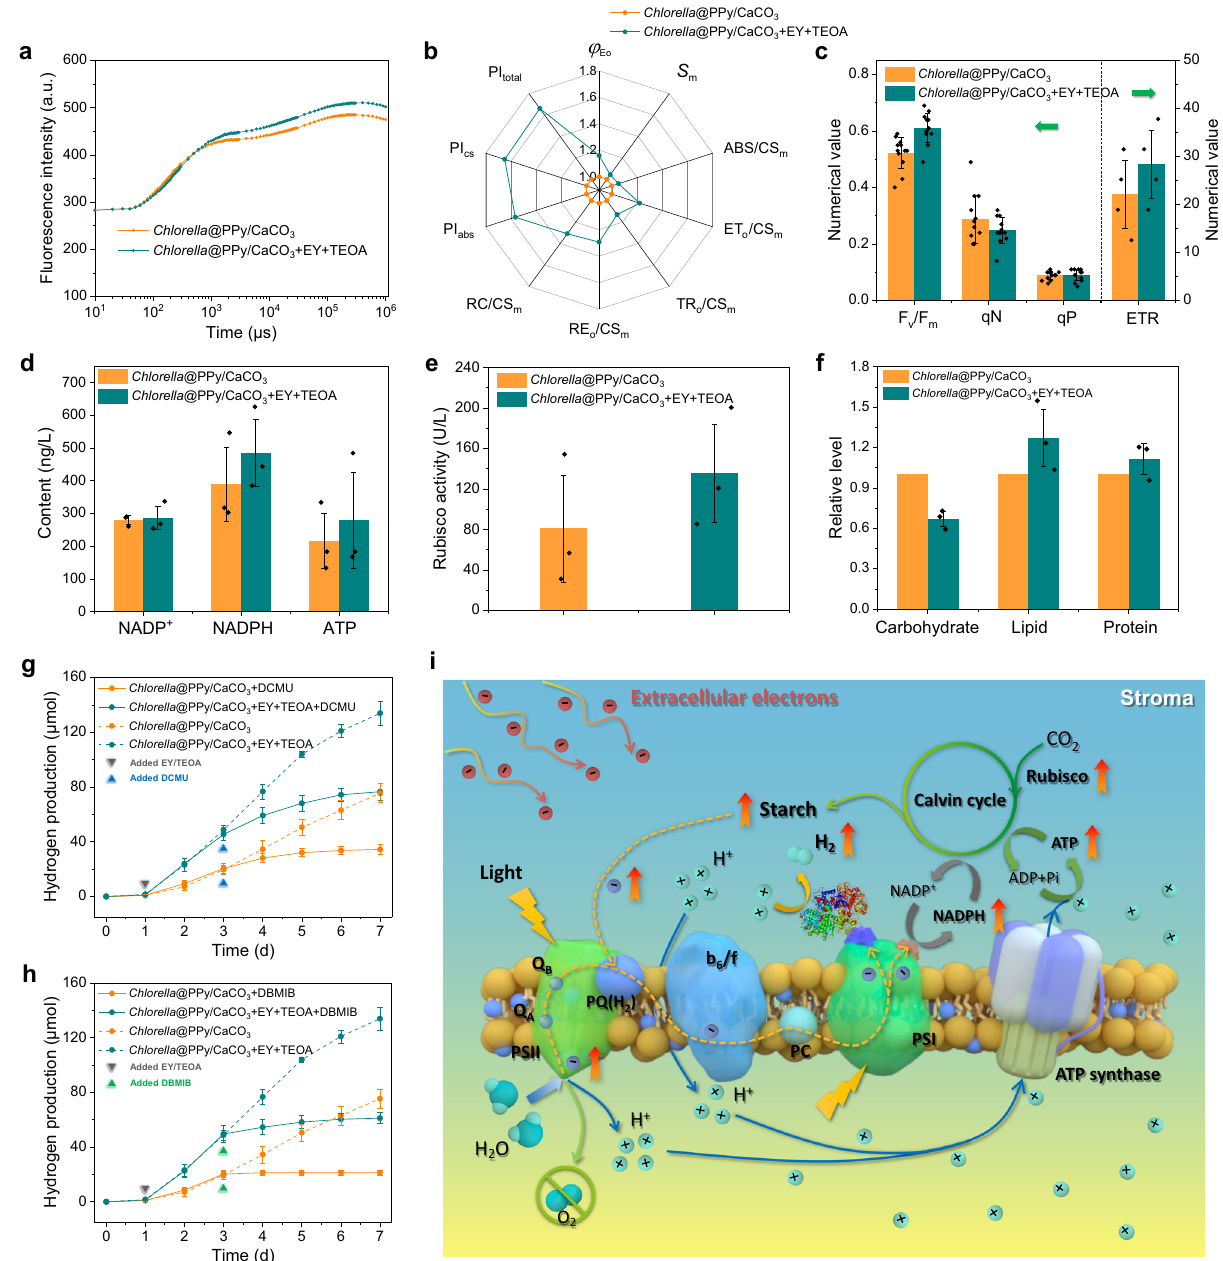
Fig.4|Roleofextracellularelectronsinsurface-conductivealgalcell-mediated hypoxic photosynthesis. a Chlorophyll fl uorescence kinetic curves for PPy/ CaCO 3 -coated Chlorella cells with or without the addition of EY and TEOA. b Corresponding spider plots of chlorophyll fl uorescence parameters from a . c – f Histograms of chlorophyll fl uorescence characteristics ( c ), NADP + , NADPH and ATPcontents( d ),Rubiscoactivity( e )andcarbohydrate,lipidandproteincontents ( f ) for PPy/CaCO 3 -coated Chlorella cells with or without EY and TEOA. Data are presentedasmeanvalues±SD,errorbarsindicatestandarddeviations( n =12( c , F v / F m , qN , qP ), n =4 ( c , ETR), n =3 ( d , e , f ), biologically independent samples). g , h Time-dependent measurements of hydrogen production for DCMU- ( g ) or DBMIB-treated ( h ) PPy/CaCO 3 -coated Chlorella cells withor withoutadditionofEY and TEOA (solid lines).The corresponding un-inhibited hydrogen production data